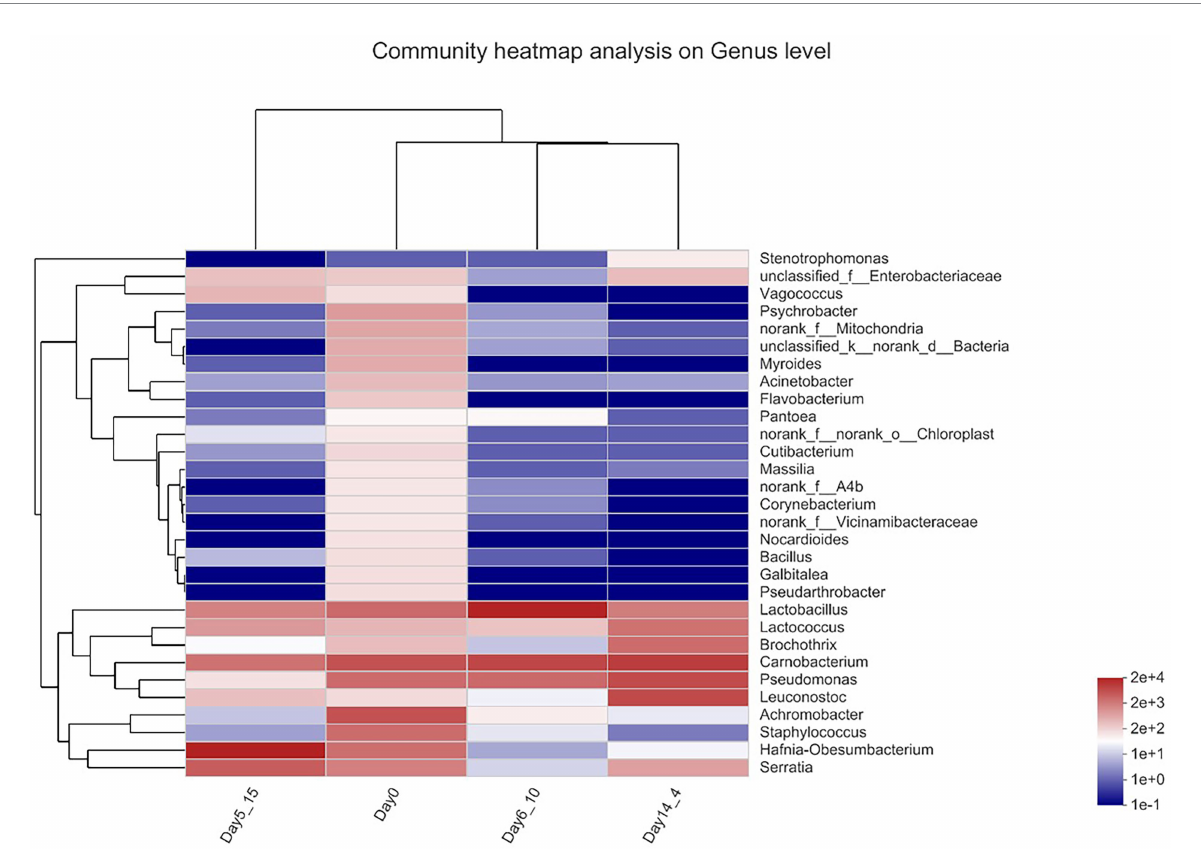
FIGURE 4 Heatmap of bacterial genera in beef samples found on beef samples aging 14 days at 4 ° C, aging 6 days at 10 ° C and aging 5 days at 15 °